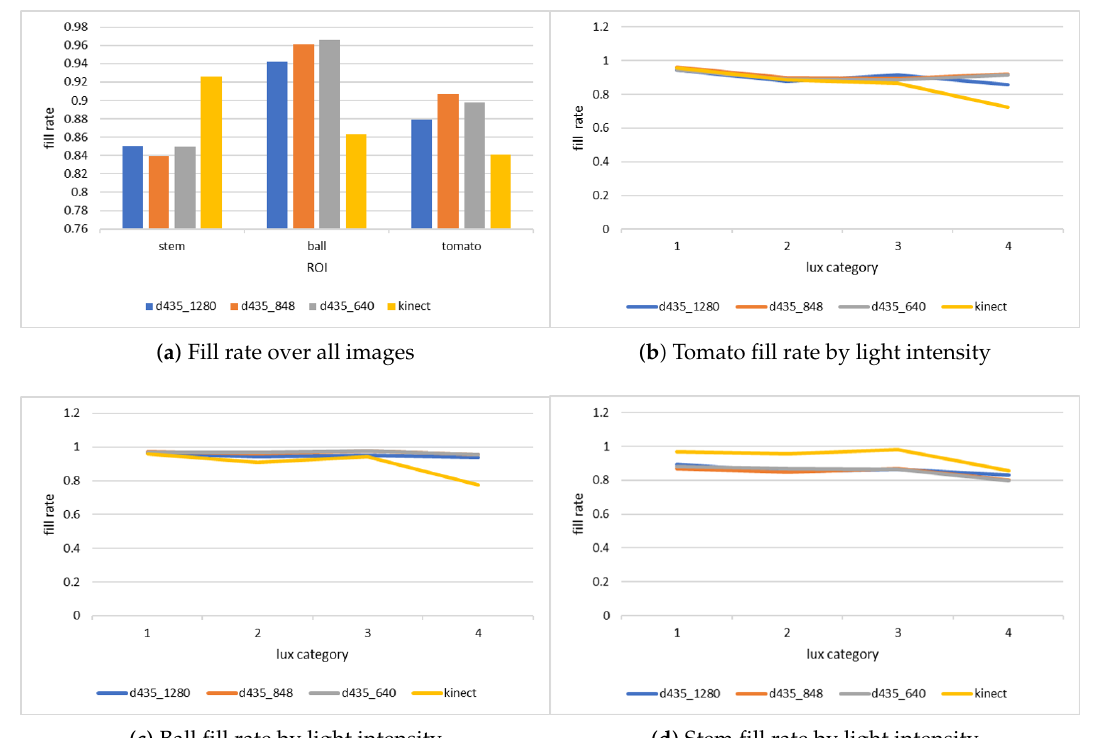
Figure 5. Comparing fill rate for different objects